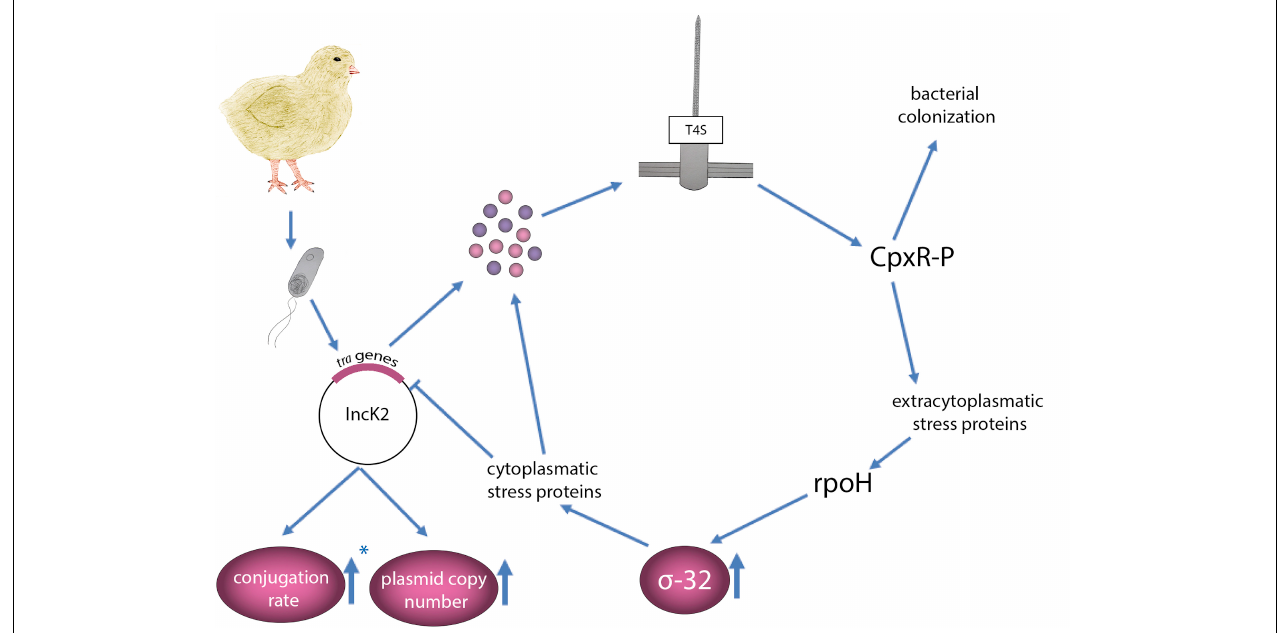
FIGURE 5 | Schematic presentation of the environmental context to the plasmid induced bacterial stress model adapted from Zahrl et al. (2006), which explains the high prevalence of IncK2 (and not IncK1) in poultry isolates. E. coli carrying an IncK2 plasmid that enters the chicken gut expresses the tra proteins. Assembly of a T4S induces extracytoplasmic stress sensed by CpxR. CpxR, which was associated with increased bacterial colonization, induces the σ -32 response encoded by rpoH gene, resulting in a further upregulation of cytoplasmic stress proteins. ∗ Arrow pointing up means less decrease in conjugation rate of IncK2 plasmid compared to IncK1 at 42 ◦